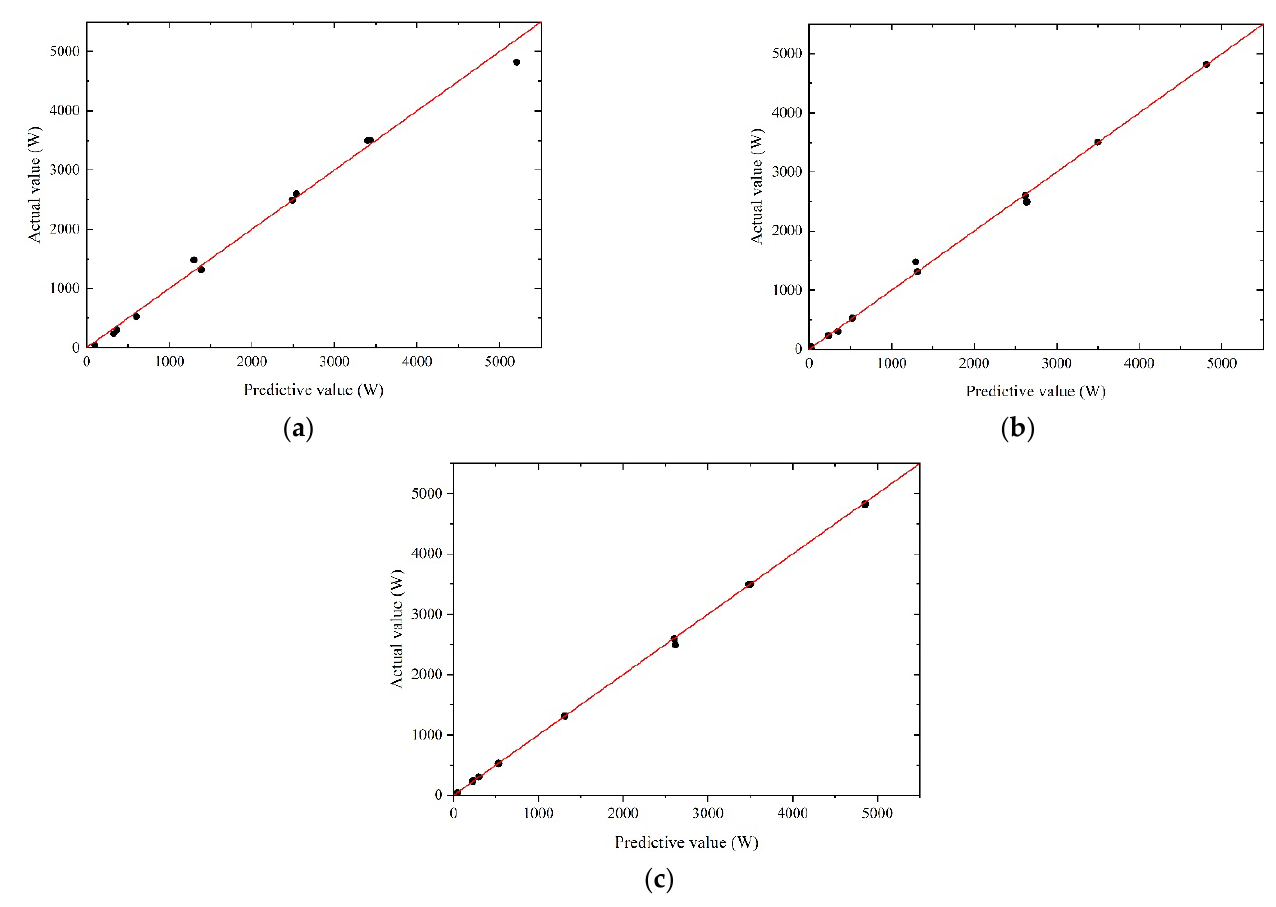
Figure 9. Prediction models error analysis. ( a ) RSM prediction model error analysis. ( b ) RBFNN prediction model error analysis. ( c ) EBFNN prediction model error analysis.